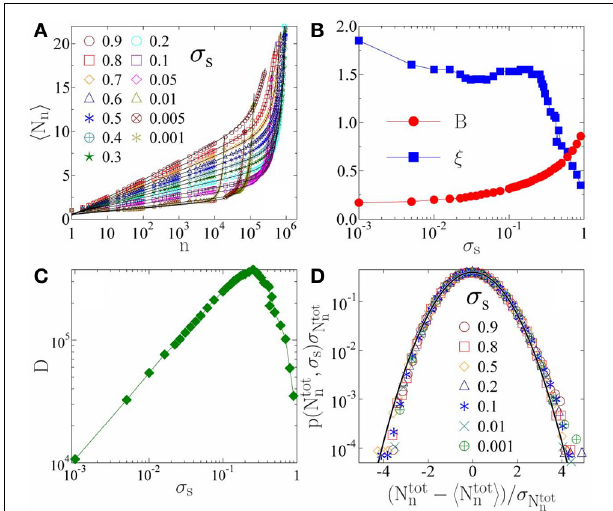
(cid:3) (cid:4) FIGURE 3 | (A) Average number of records N n as a function of the total number of avalanches n for several load values. For low record numbers logarithmic dependence is evidenced, which is followed by a faster exponential increase. The continuous black lines represent fits with Equation (3). (B,C) Fitting parameters B , ξ , and D of Equation (3) as function of the external load σ s . (D) Probability distribution of the total number of records N tot n occurred up to failure for several load values. The distributions obtained at different loads are rescaled with the corresponding average and standard deviation. The continuous line represents the standard Gaussian Equation